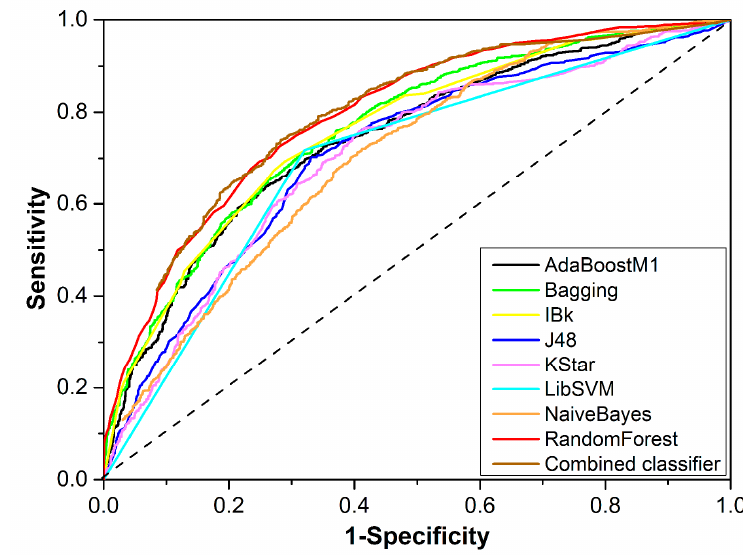
Figure 2. Receiver operating characteristic curves of the eight best single classifiers and the combined classifier.